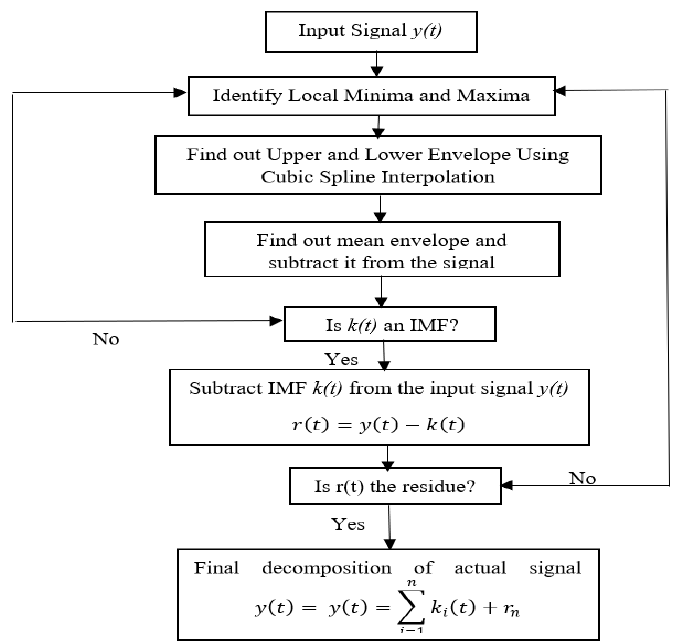
Figure 1. Flowchart of the EMD algorithm.